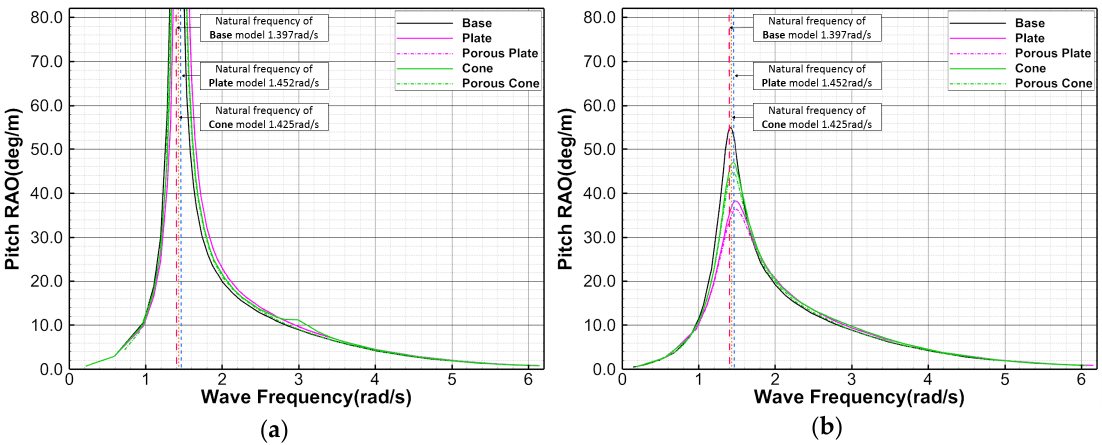
Figure 13. Pitch pitch response amplitude operators (RAOs) estimated from the potential-based motion analysis of the light buoys (a) without and (b) with the consideration of viscous damping.